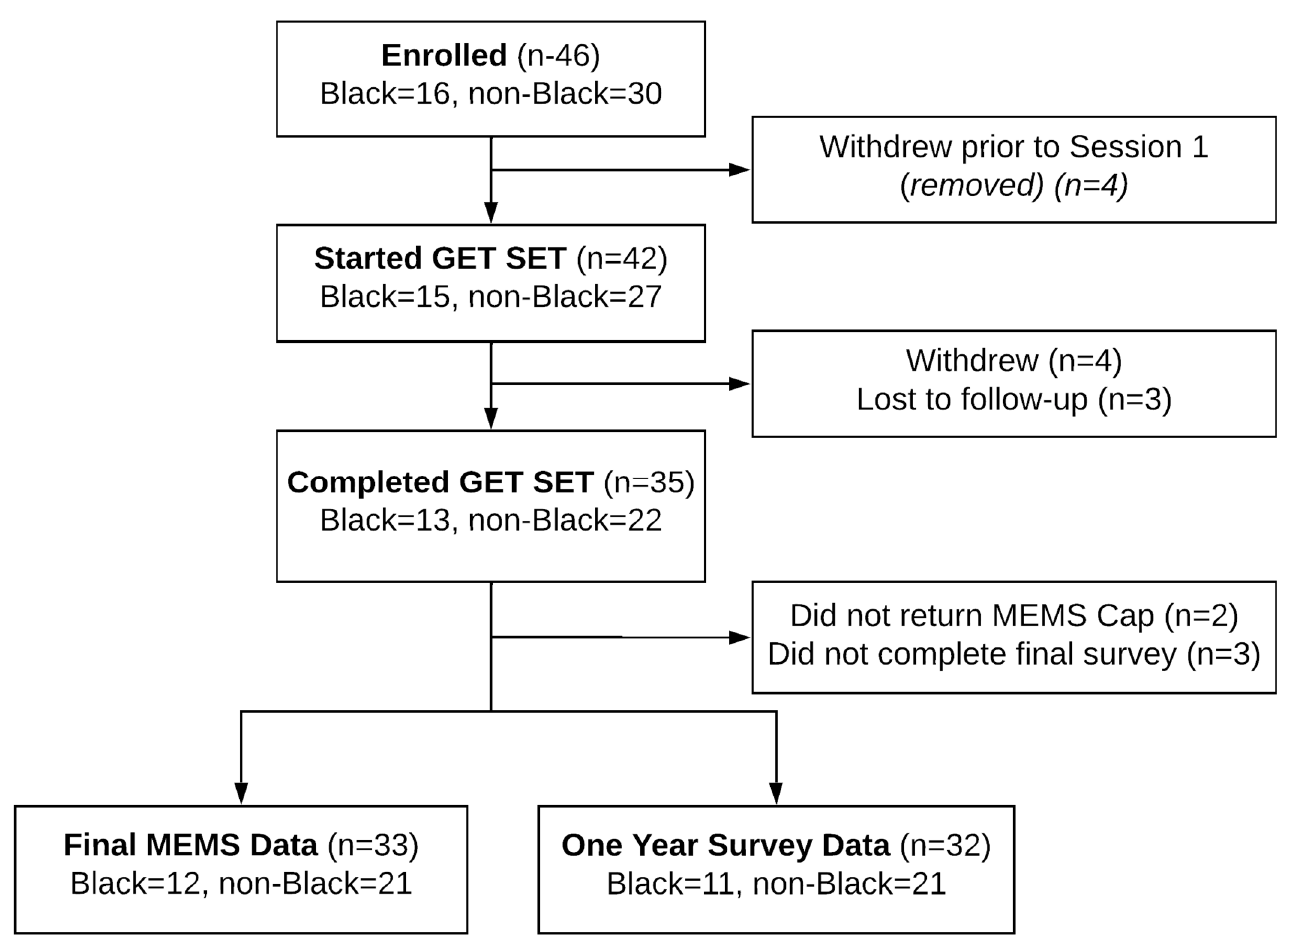
Figure 1. GETSET participant enrollment and study completion diagram.